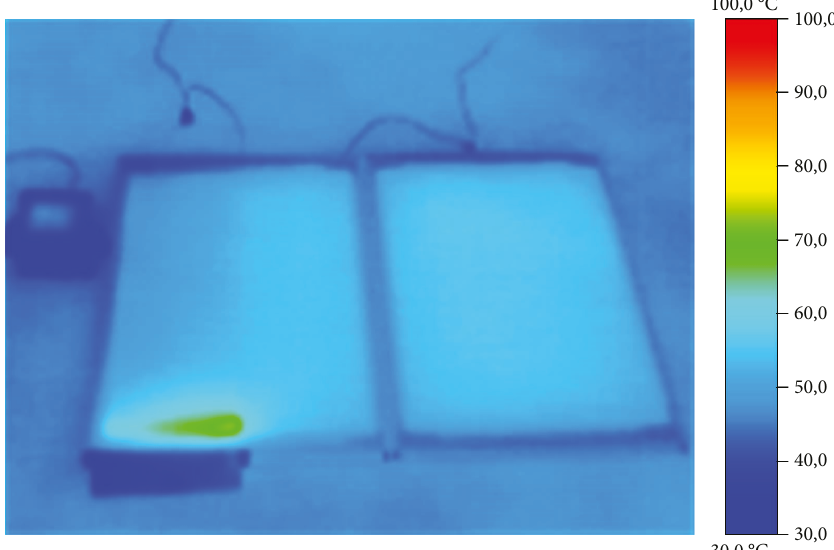
V = 26V ). 26 September 2017, Aversa (CE), Italy. 3 ( PV = 25 ° C . amb